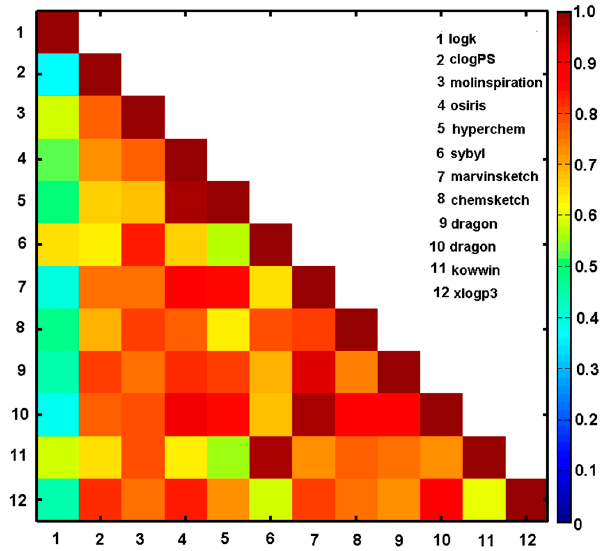
Figure 2. Matrix of correlation coefficients of linear relationships between experimental lipophilicity (log k 1 ) and calculated lipophilicity for series 1 – 26 .